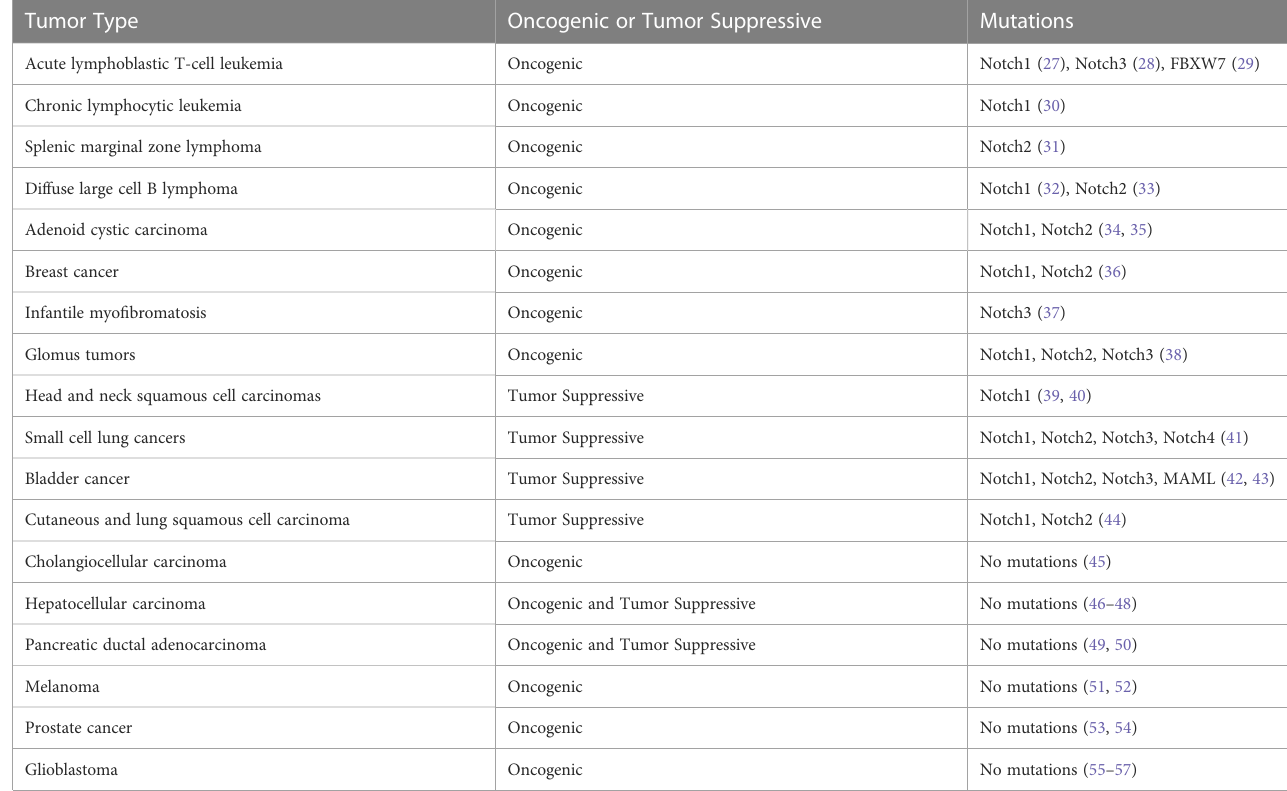
TABLE 1 The Oncogenic and tumor suppressive roles of Notch signaling in human cancers.